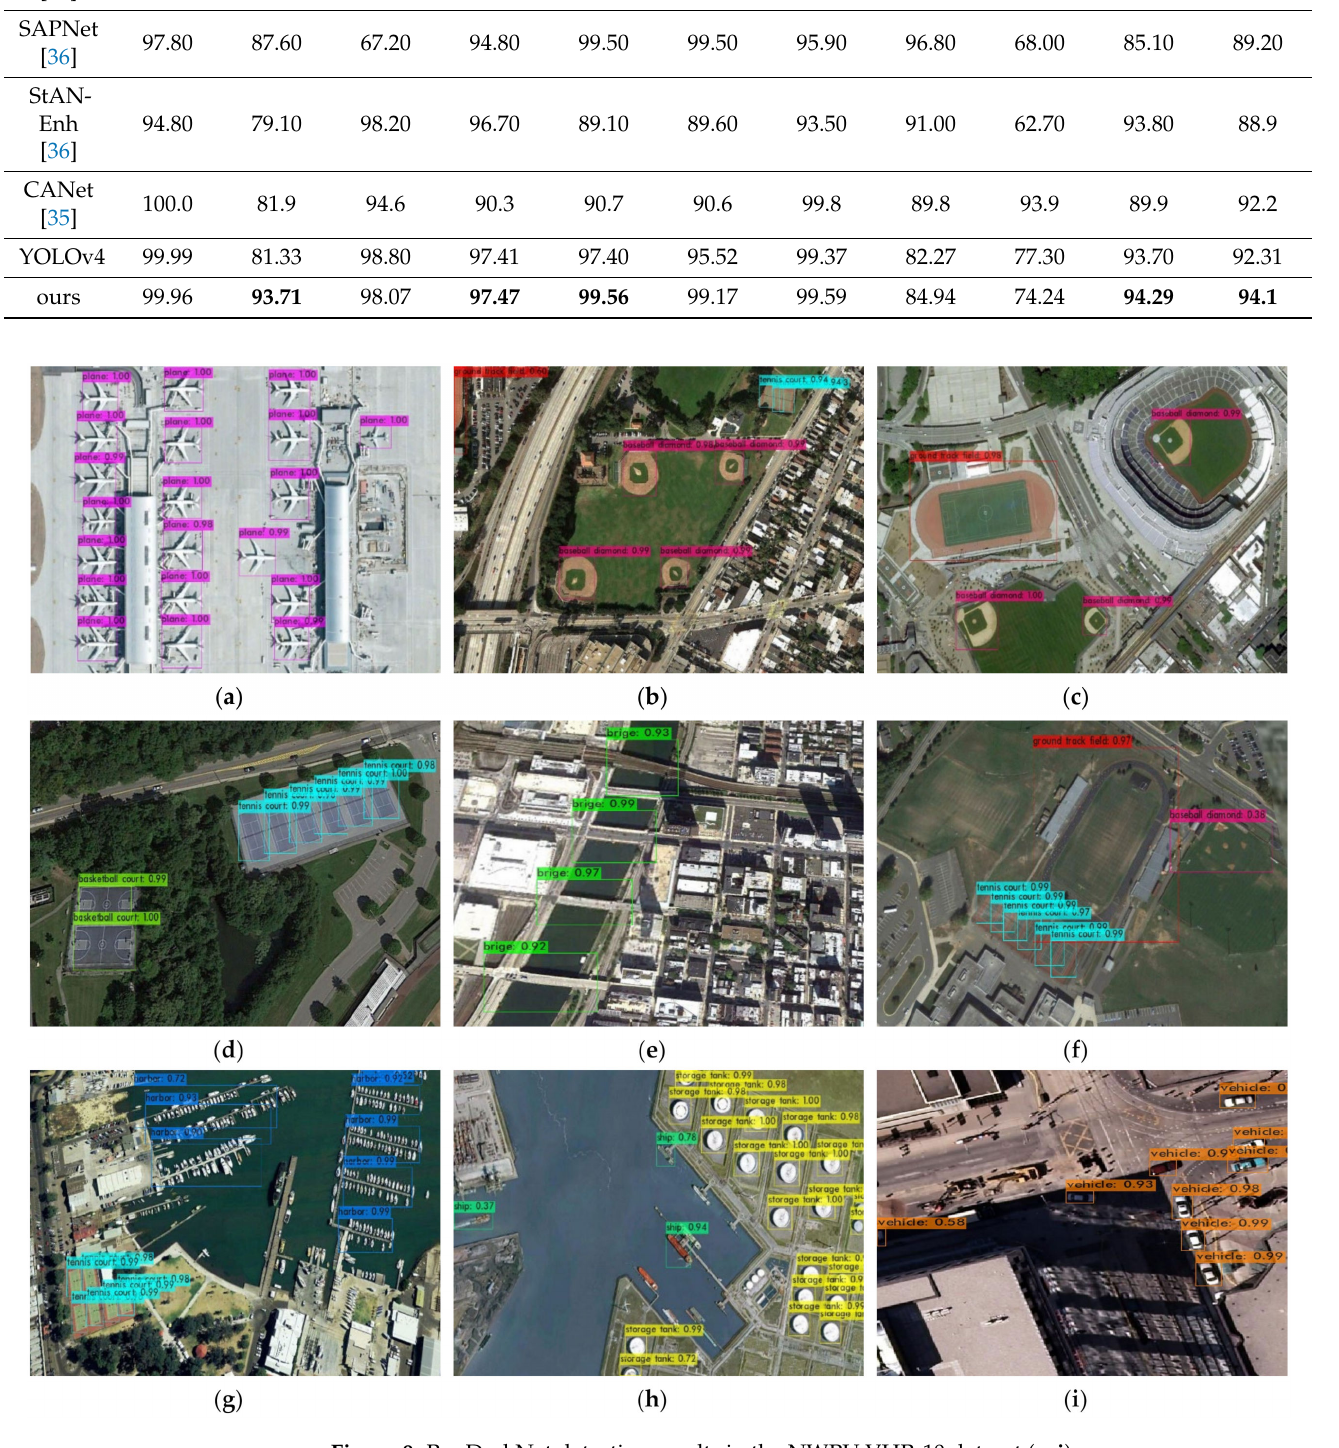
Figure 9. RepDarkNet detection results in the NWPU VHR-10 dataset ( a – i